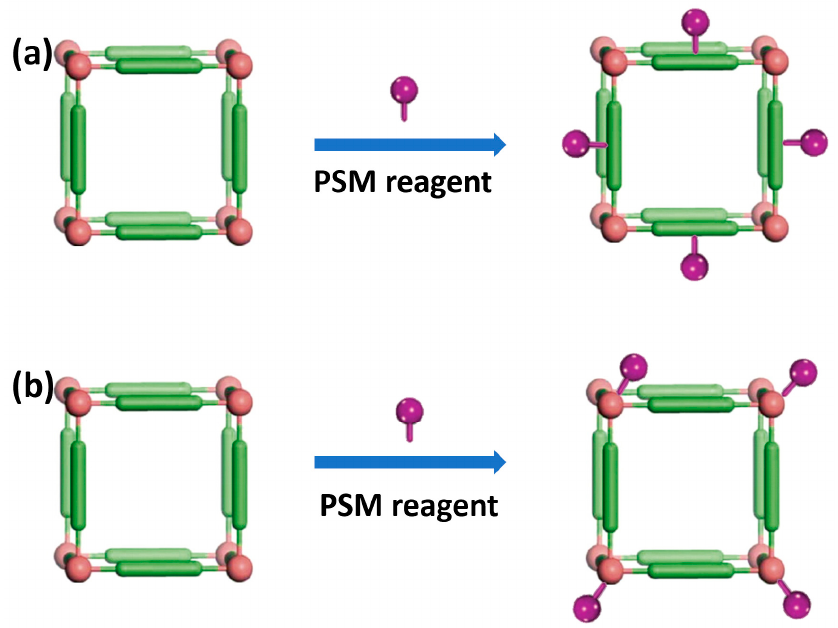
Figure 3. Schematic illustration for the surface modification of MOFs.